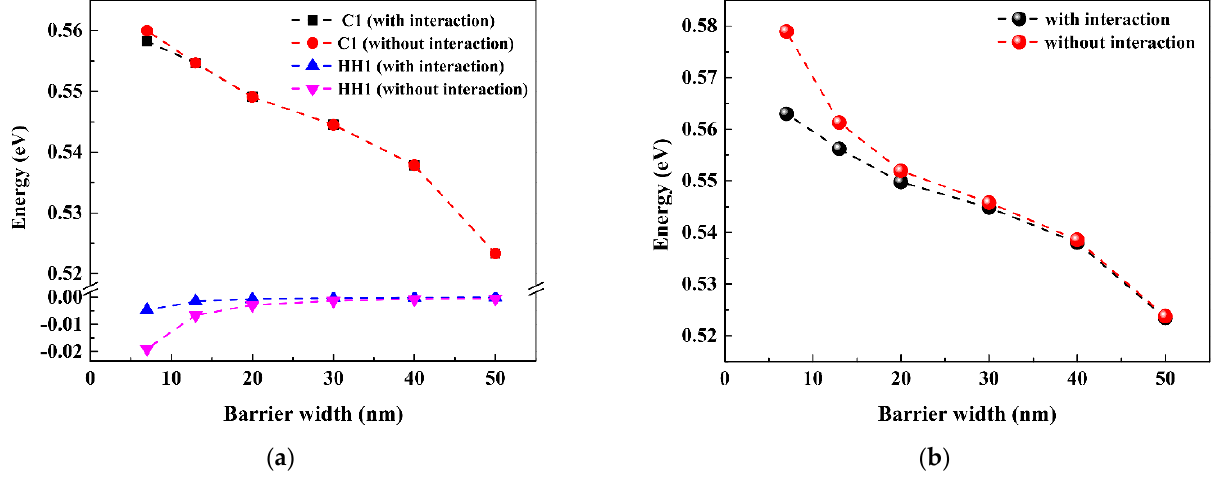
Figure 3. Variation of ( a ) conduction- and valence-confined energies (C1 and HH1, respectively) and ( b ) first transition energies for various barrier thicknesses with and without interaction terms.